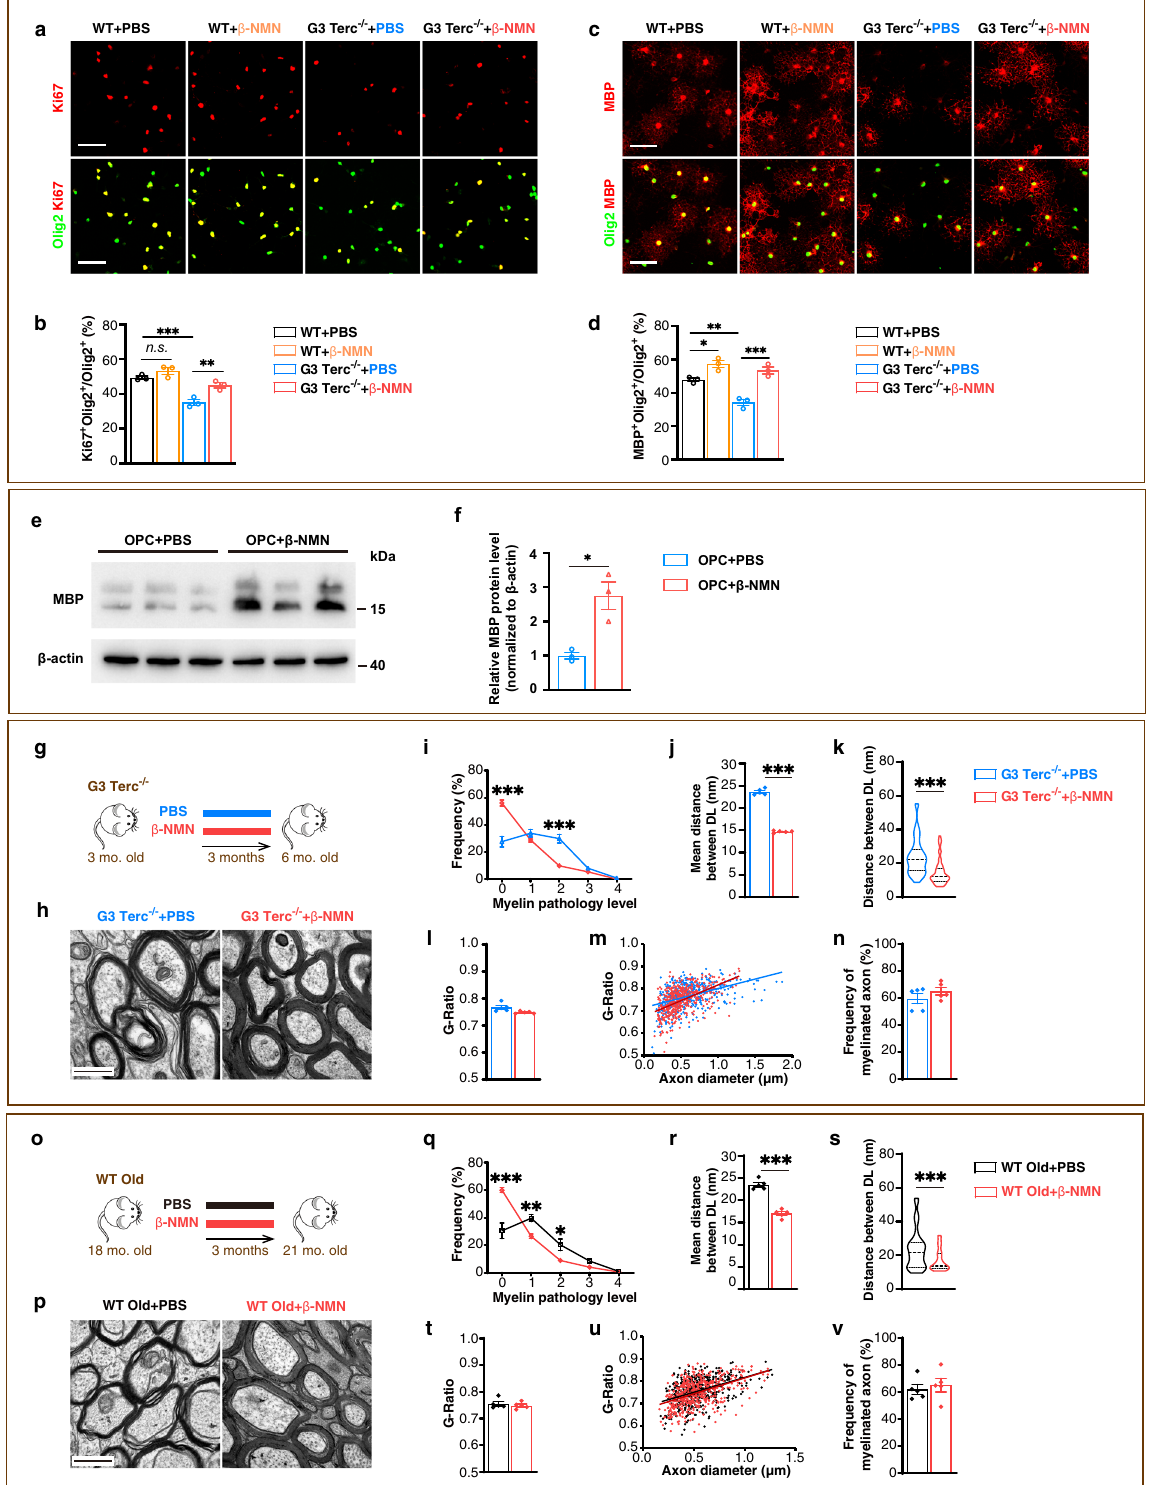
decreased the elevated mRNA level of ID4 to less than half (Fig. 7 f) but did not change the mRNA level of ID2 (Supplementary Fig. 13a). In OPCs of WT mice, β -NMN also downregulated the protein level of ID4 (Fig. 7g – h), which was inversely correlated with β -NMN induced upregulation of MBP (Fig. 4e – f). Since we have established that impaired differentiation of OPCs is the key pathology for SIRT2 − / − mice (Fig.